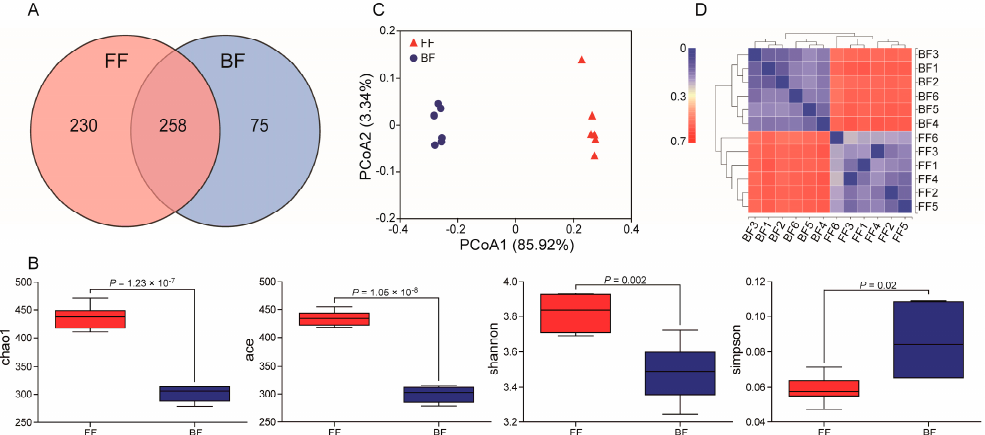
Figure 2. Microbial community structure: ( A ) Venn diagram of operational taxonomic units (OTUs); ( B ) α -diversity; ( C ) Principal coordinate analysis (PCoA) on unweighted UniFrac distances; ( D ) Heat map matrix of β -diversity. The larger the index, the greater difference between samples.